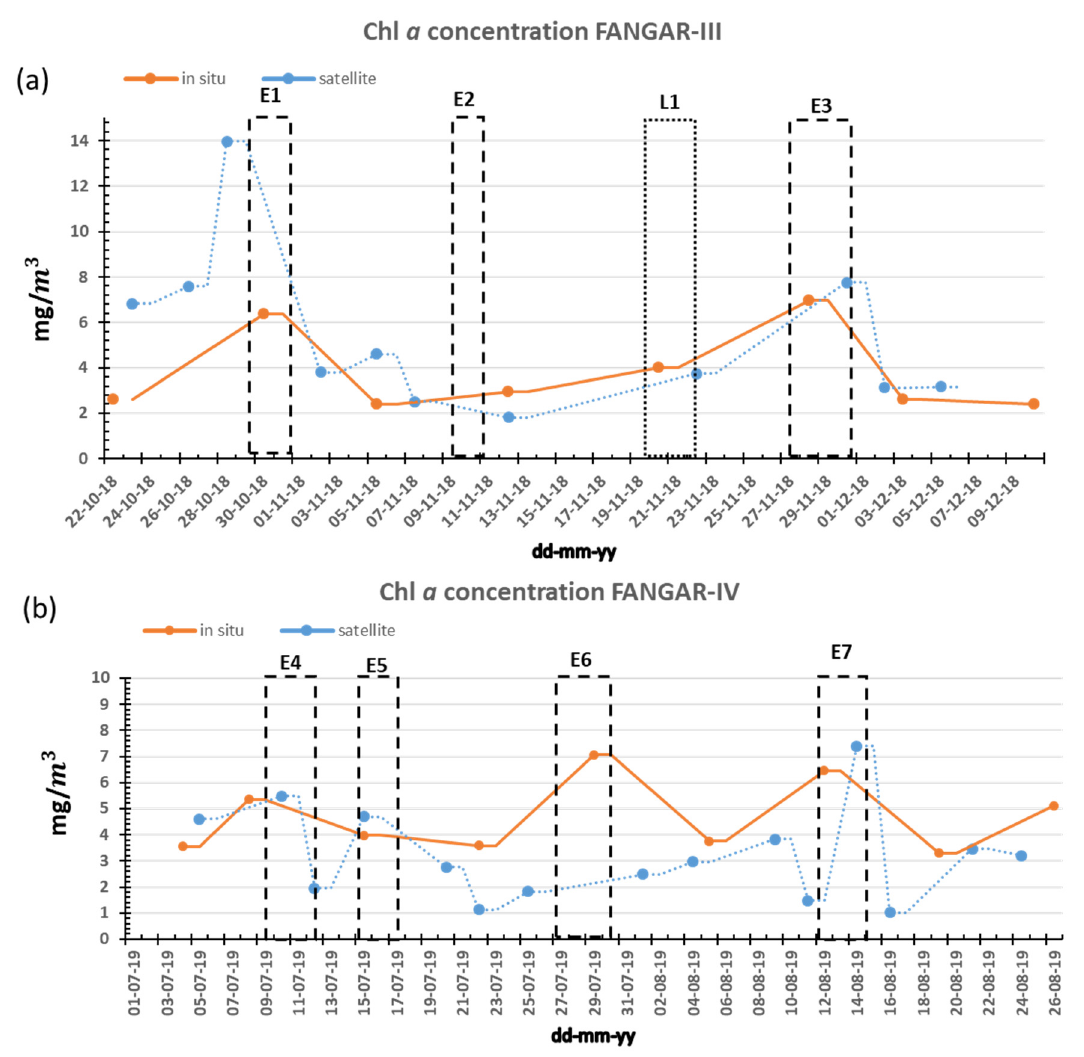
Figure 5. Time series of Chl a concentration in situ and satellite images, at a central point in the bay for FANGAR-III ( a ) and FANGAR-IV ( b ). The boxes with dashed line mark the episodes of the NW wind, while the dotted box marks the episodes of the E-NE wind.